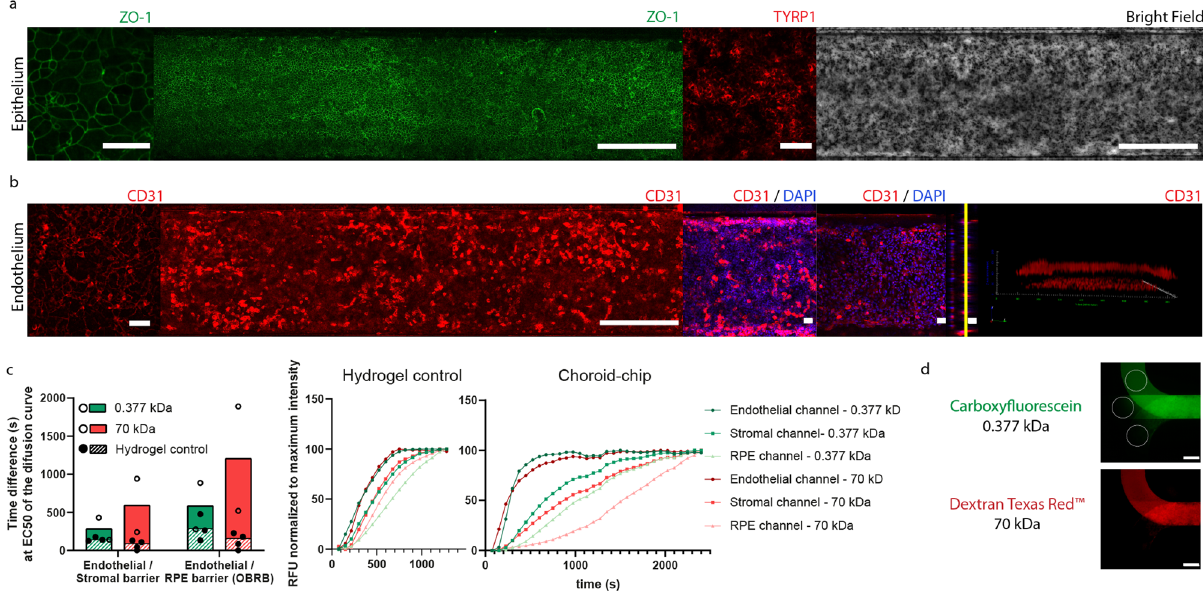
Fig. 2 Endothelial and outer blood-retina barrier (oBRB) characterization after 2 weeks in culture. a Immuno fl uorescence staining demonstrating the phenotype and structure of the retinal pigmented epithelium as a con fl uent monolayer expressing the tight junction marker zonula occludens (ZO-1, in green) at high magni fi cation (left) and throughout the whole cell culture surface on the chip (middle, long image of ZO-1, in green) as well as melanin production, demonstrated by the expression of TYRP1 (red) and pigmentation demonstrated in the bright fi eld imaging (right, gray). b Immuno fl uorescence staining demonstrating the phenotype and structure of the endothelium formed by microvascular endothelial cells positive for CD31 (red), presenting a stronger staining in the cell junctions when cultured in the absence of RPE and melanocytes (left) than in co-culture (middle, long image of CD31, in red). The DAPI/CD31 staining represents the bottom endothelial layer (left), top endothelial layer (middle) and orthogonal side view of both, with a yellow line corresponding to the bottom membrane. The 3D render (right) con fi rmed the presence of 2 con fl uent layers. ( c ) Quanti fi cation of the relative permeability of the endothelial (MVEC)/stromal and oBRB barriers when perfused with low (Carboxy fl uorescein, 0.377 kDa) and high molecular weight (Dextran Texas Red, 70 kDa) fl uorescence molecules. Relative permeability is presented as a measure of the lag time difference to achieve 50% of the compound concentration (right) extracted from the molecule diffusion kinetic curve ( n = 2 for the CoC and n = 3 for the Hydrogel control, bars represent SEM) (left) and a representation of the kinetic pro fi le measured for one chip, normalized to the highest fl uorescence intensity in each channel of the CoC and for both molecular weight molecules. d Representative images of the fl uorescent measurements, labeled with white circles, performed to quantify relative permeability. The measurements were performed in each of the individual channel, where there is no channel overlap, on the inlet side of the chip. The top circle corresponds to the MVEC channel, the middle to the stromal channel and the bottom to the RPE channel. The images show a fl uorophore fi lled MVEC channel after 552 s of perfusion. Scale bars are 500 µ m, except for square images and the orthogonal view in in ( a ) and ( b ), where the scale bars represent 50 µ